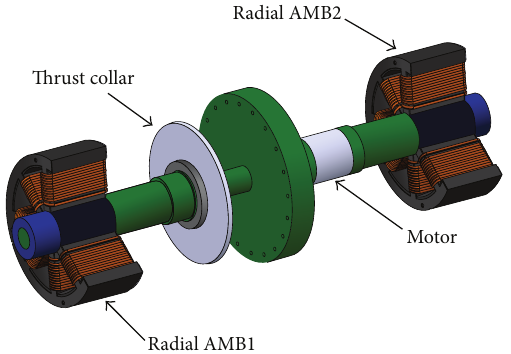
Figure 2: The rotor and radial AMBs in the controller test bed.